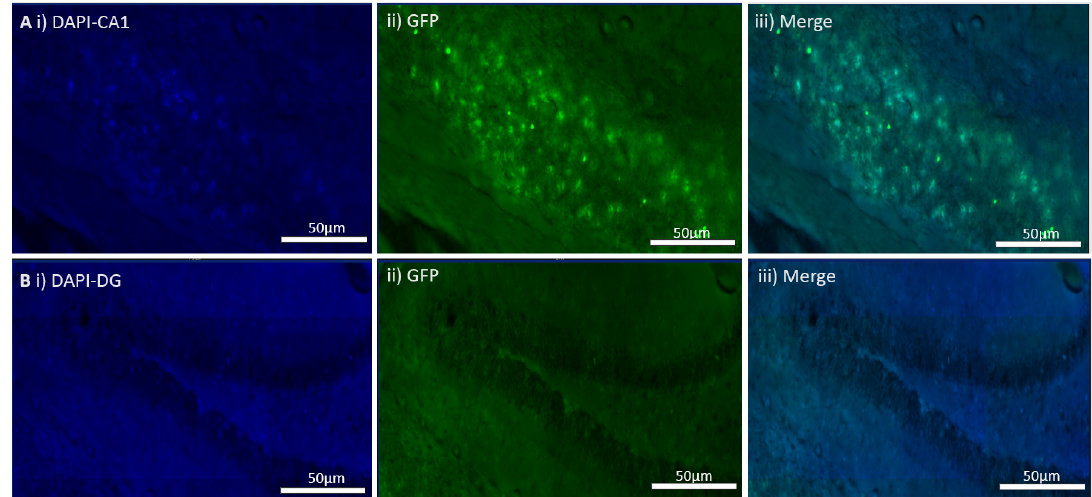
Figure 4. In vivo virus transduction of the hippocampal CA1 from MEN1 floxed mice in CA1 region of hippocampus and dentate gyrus (DG). ( A ) Expression of GFP in CA1 in the CKO; ( i ) the expression of DAPI for nuclear staining in CA1; ( ii ) the expression of GFP as the marker of virus transduction in the neurons transduced by the AAV9 under the action of synapsin promoter in CA1; ( iii ) merge in controls with control virus AAV9 GFP and overlap between DAPI and GFP; ( B ) non-GFP expressing region in dentate gyrus (DG); ( i ) the expression of DAPI for nuclear staining in DG; ( ii ) GFP signal in the non-transduced region of hippocampus; ( iii ) merge for showing the overlap between DAPI and GFP.